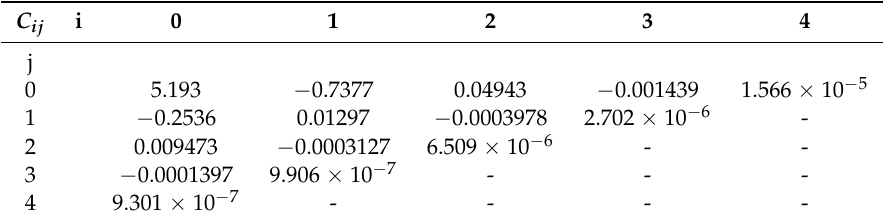
Table 6. Surface Polynomial Coefficients for Class 2.